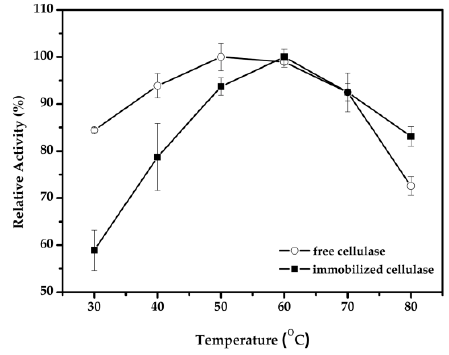
Figure 7. Effect of temperature on the activity of immobilized cellulase.